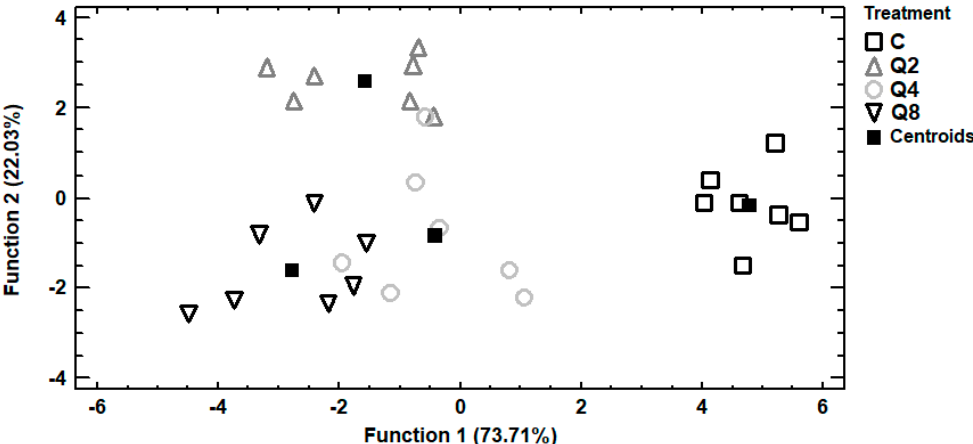
Figure 3. Discriminant plot separating egg yolk samples, according to the dietary treatment, based on trace and macro elements.